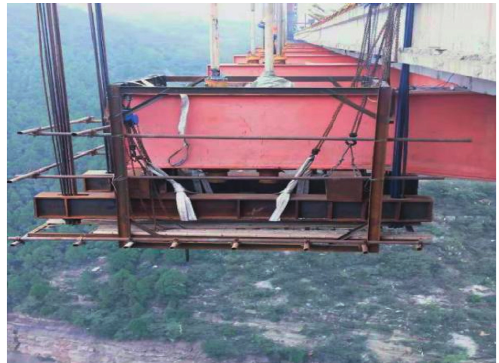
Figure 15: Lower reaction beam.